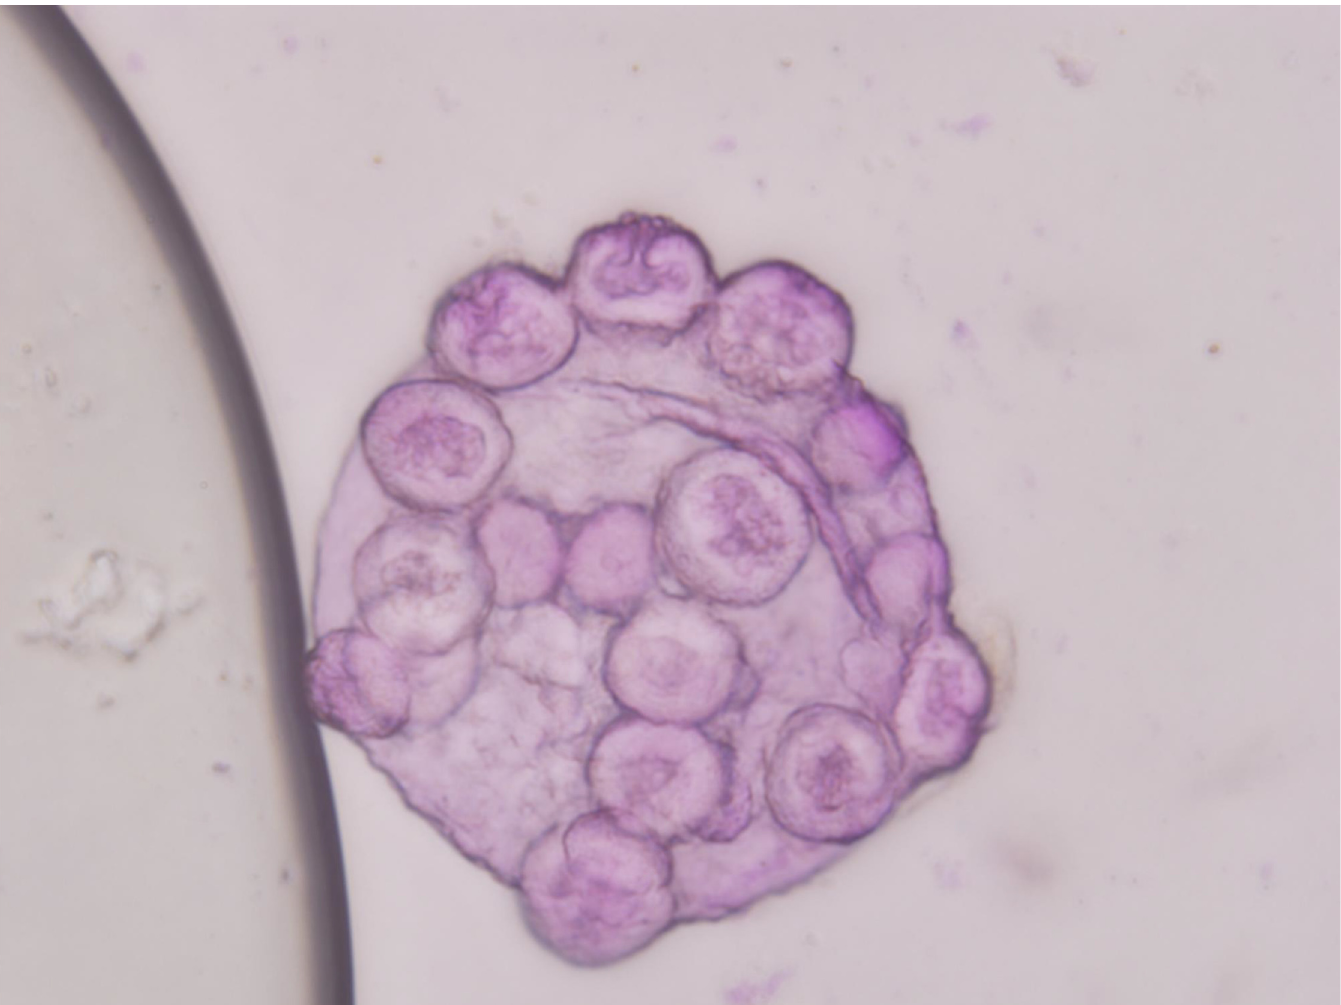
Fig 5. Various abnormal pollen grains of this triple hybrid.